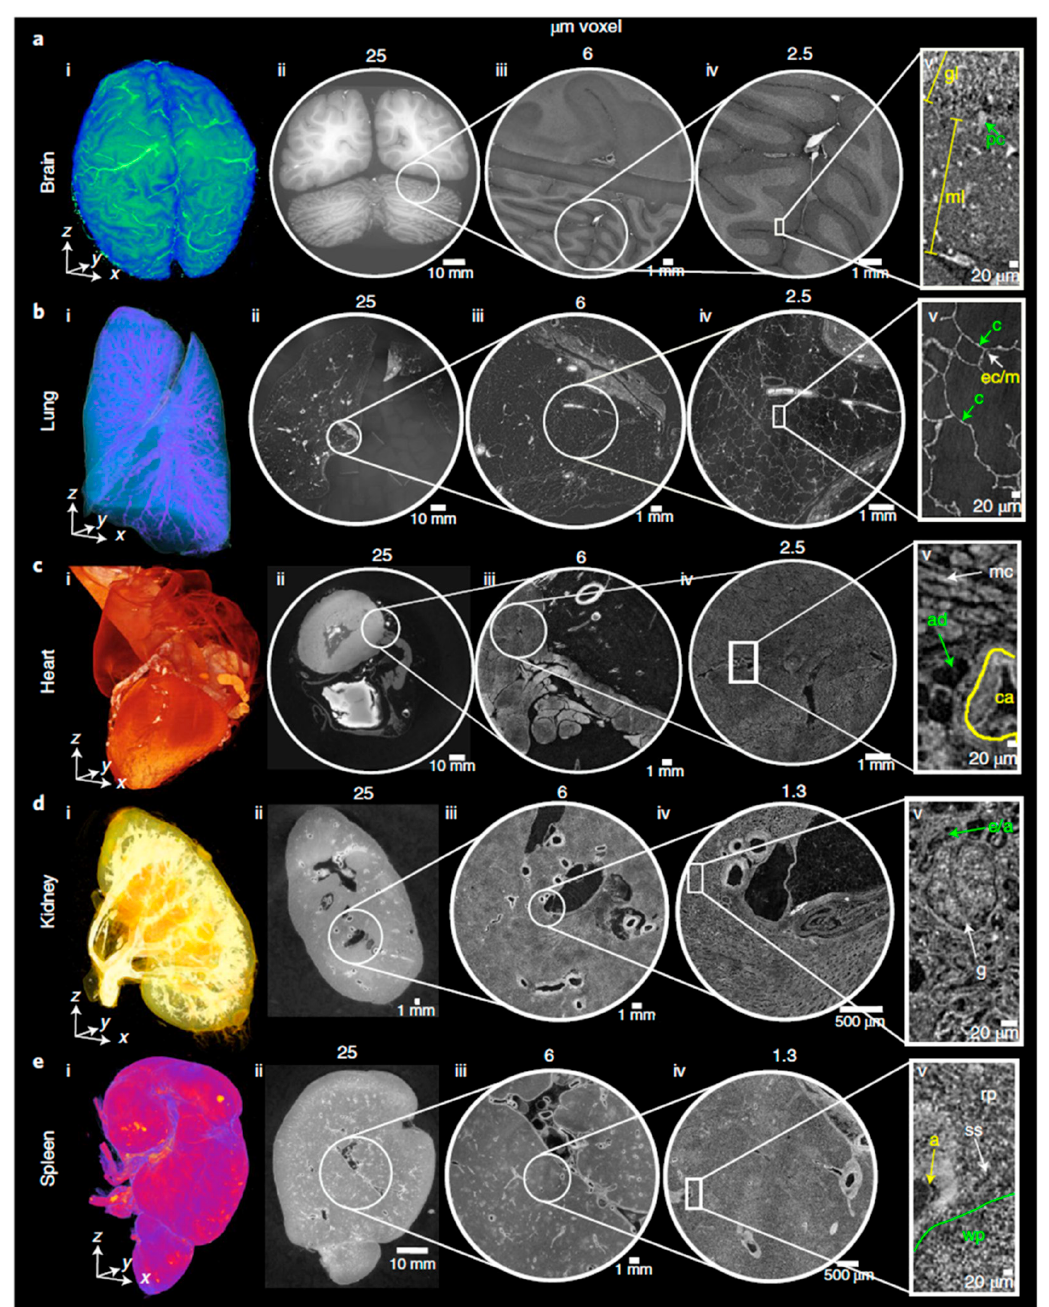
Figure 8. Hip-CT images of ( a ) brain, ( b ) lung and ( c ) heart at voxel size 25 μ m (column ii), 6 μ m (column iii) and 2.5 μ m (column iv), respectively. ( d ) Kidney and ( e ) spleen images at voxel size 25 μ m (column ii), 6 μ m (column iii) and 1.3 μ m (column iv), respectively. Reprinted with permission from [42].